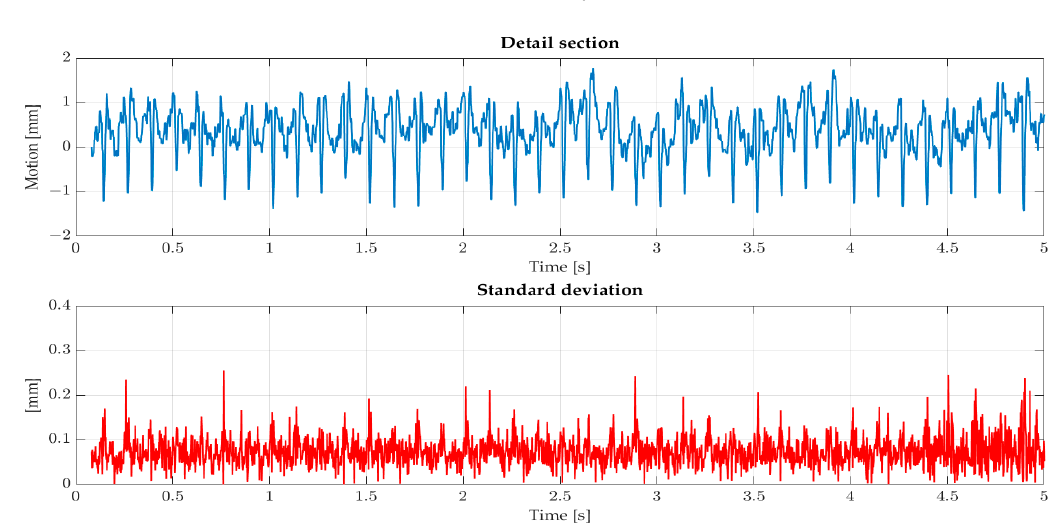
Figure 12. Detail of section of blade deflection with steady inflow without the constant offset is shown as a blue profile. The standard deviation is shown as a red profile. Both profiles have different scaling.